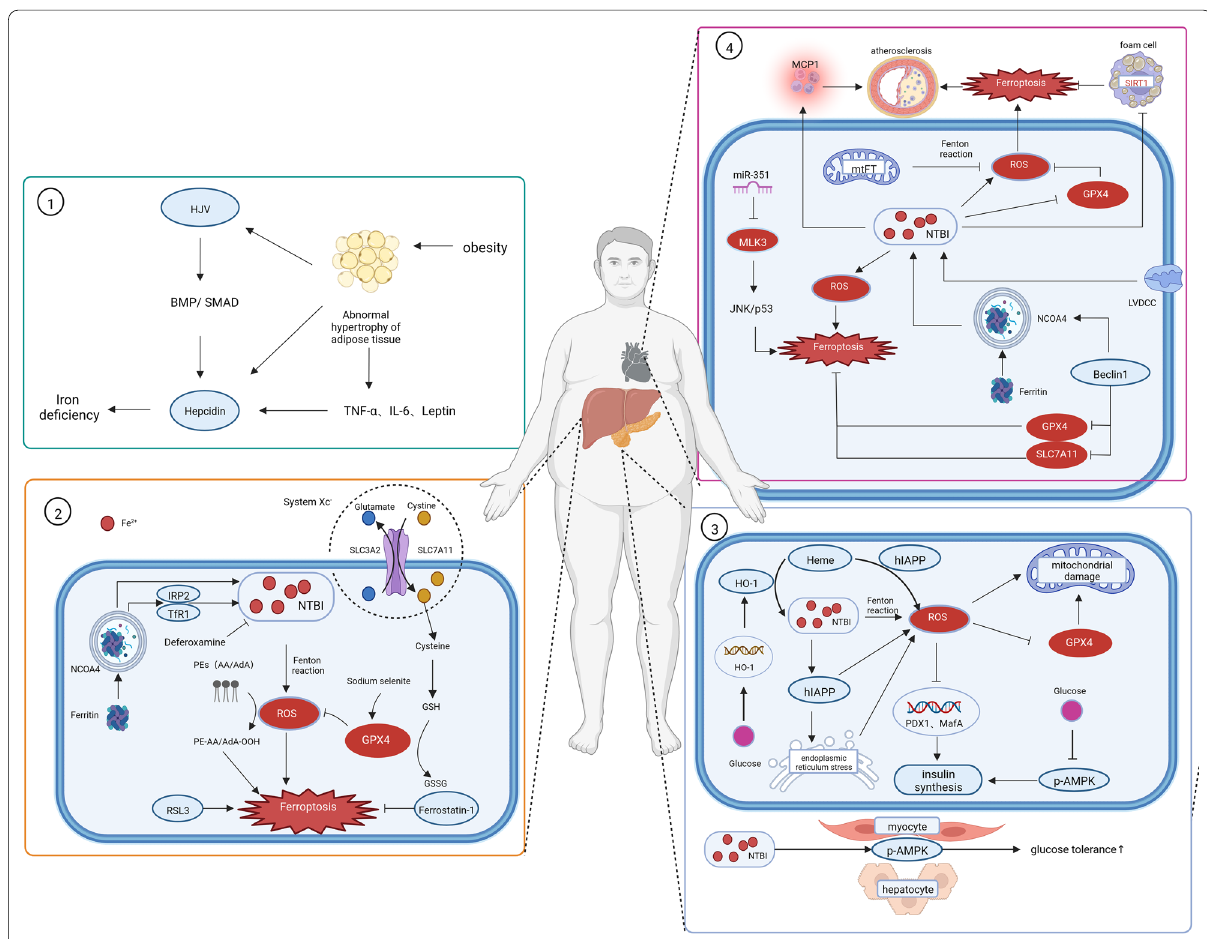
Fig. 2 Schematic diagram of the relationship between iron metabolism disorder and obesity and related metabolic diseases. Hepcidin over-expression can induce iron deficiency, and hemojuvelin (HJV) can promote hepcidin expression through the BMP/SMAD signaling pathway. ① In obese individuals, adipose tissue can regulate expression of hepcidin and HJV through overproduction of pro-inflammatory adipokines including IL-6, TNF-α and leptin; meanwhile, it also directly expresses hepcidin and HJV at high levels, which contribute to iron deficiency in obese individuals. ② The role of iron overload and ferroptosis in nonalcoholic fatty liver disease (NAFLD). Nuclear receptor coactivator (NOCA)4 contributes to iron overload by translocating ferritin to lysosomes and increasing the expression of iron regulatory protein (IRP)2 and transferrin receptor (TfR). Lipid peroxidation of membrane phospholipids can be eliminated by parallel metabolic pathways, including the cyst(e)ine/GSH/ GPX4 axis, as well as the ferroptosis inducer (RSL3). In addition, several ferroptosis inhibitors such as sodium selenite (GPX4 activator), deferoxamine (iron-chelating agent) and ferrostatin-1 (ferroptosis inhibitor) can alleviate the onset and progression of NAFLD. ③ Iron-mediated toxic effects in beta-cells. Iron-mediated beta-cell toxicity is mainly due to reactive oxygen species (ROS) accumulation through the Fenton reaction. Excess ROS causes mitochondrial damage, leading to defects in the synthesis and secretion of insulin. ROS also influences the activity of the PDX1, MafA and AMPK, critical transcription factors for the control of insulin gene expression. In turn, hyperglycemia increases heme oxygenase (HO)-1 gene expression, exacerbates iron overload, promotes oxidative stress and the development of T2DM. In addition, misfolding and aggregated deposition of human islet amyloid polypeptide (hIAPP) due to iron overload can also lead to oxidative stress through endoplasmic reticulum stress, mitochondrial damage and complex formation by binding to heme. Besides, iron overload can stimulate glucose uptake and fatty acid oxidation by activating AMPK phosphorylation in skeletal muscle and liver, leading to an increase in glucose tolerance. ④ The relationship between iron overload and cardiovascular disease. Accumulation of iron in the heart has been supposed to depend on the penetration of Fe 2 + through the L-type voltage-dependent Ca 2 + channel (LVDCC). Non-transferrin-bound iron (NTBI) promotes atherogenesis by leading to ROS production through the Fenton reaction and stimulating monocyte chemotactic protein (MCP)1-mediated monocyte aggregation. In addition, iron overload inhibits SIRT1 and glutathione peroxidase (GPX)4, contributing to ferroptosis in foam cells and thus leading to atherosclerosis. Moreover, mixed lineage kinase (MLK)3 and Beclin1 can induce ferroptosis in cardiomyocytes through JNK/p53, and by affecting the levels of NOCA4, SLC7A11 and GPX4,